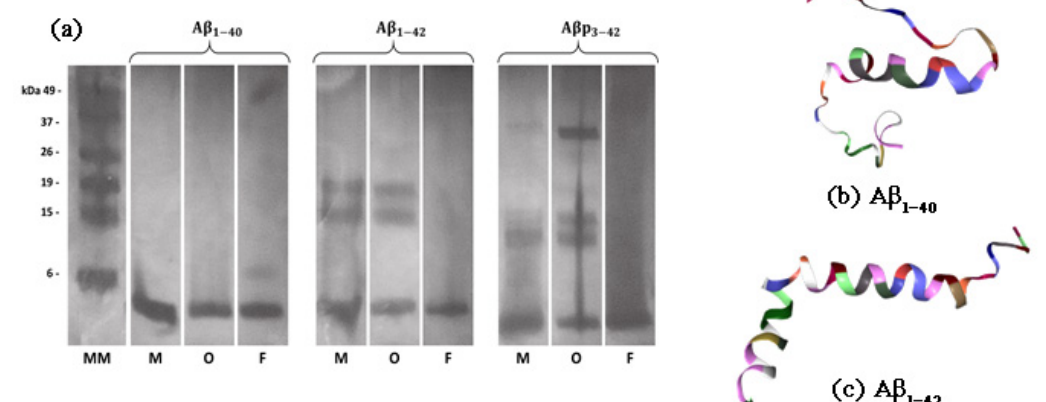
Figure 1. ( a ) Image from SDS-PAGE analysis. Silver stain of synthetic aggregates and monomers of A β 1–40 , A β 1–42 and A β p 3–42 peptides. In monomeric preparations the peptides show a band at (cid:39) 4 kDa; A β 1–42 and A β p 3–42 form spontaneous aggregates of low molecular weight (in the 11–19 kDa range). Synthetic A β 1–42 and A β p 3–42 show bands of low and high molecular weight in aggregating conditions, while synthetic A β 1–40 did not form oligomers and fibrils in the same conditions. The letters under the images describe the aggregation state of the samples (M = monomers, O = oligomers, F = fibrils) while the leftmost image is the molecular marker reference. The structure of ( b ) A β 1–40 (PDB ID 2LFM) and ( c ) A β 1–42 (PDB ID 1IYT) is shown on the right